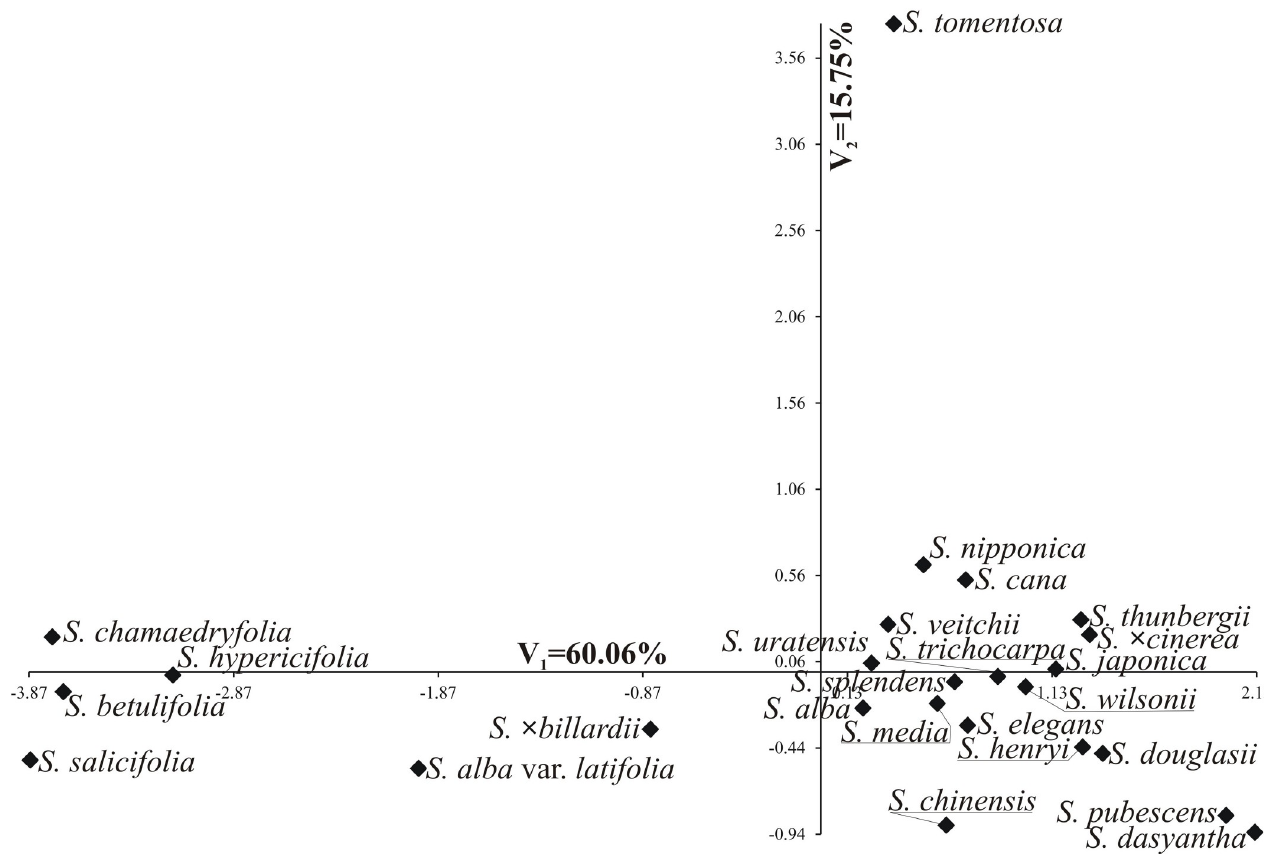
Fig 13. Distribution of 28 Spiraea taxa in space of two first canonical variables.